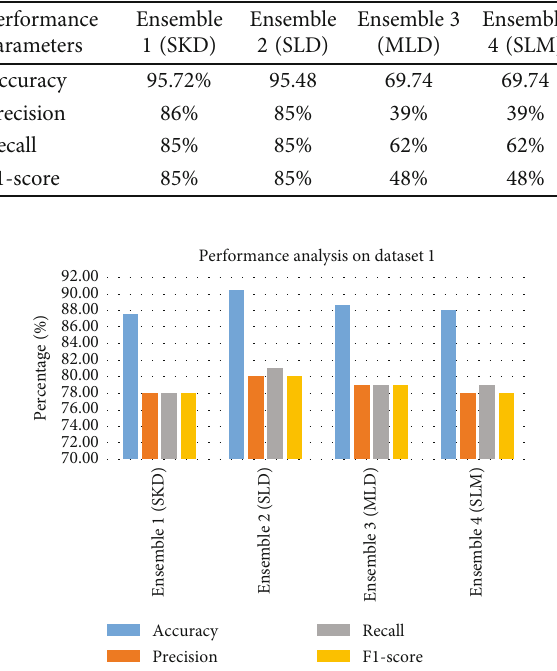
Figure 6: Performance analysis on dataset 1.